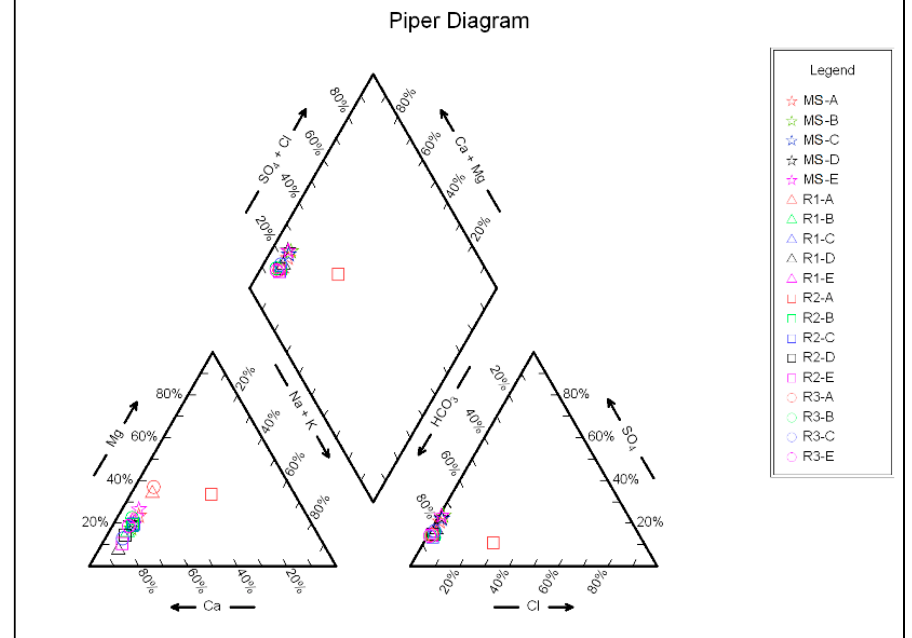
Figure 10. Piper diagram, including all sampled waters in the four sampling campaigns. The samples are referred to in Table 2. The apexes of the cation ternary plot are calcium, magnesium, and sodium plus potassium. The apexes of the anion plot are sulphate, chloride, and carbonate plus hydrogen carbonate.